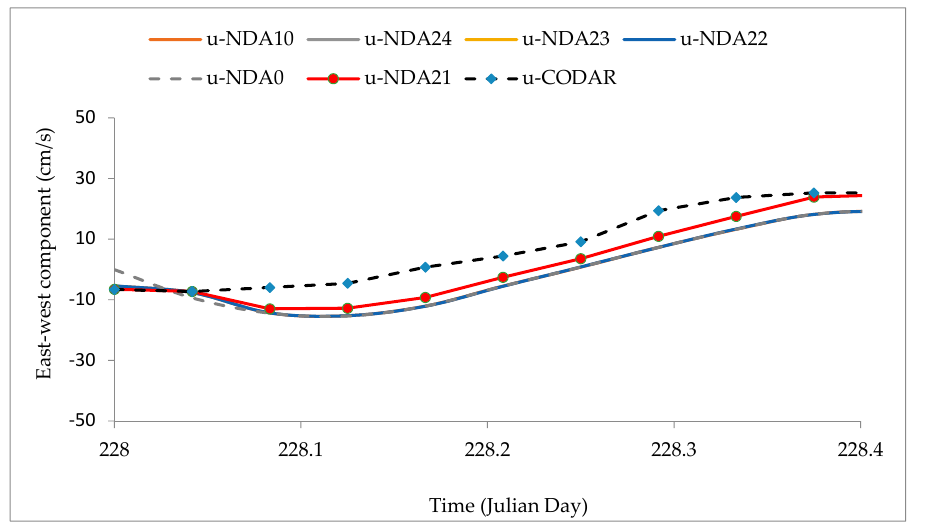
Figure 8. Time series of east–west velocity component.